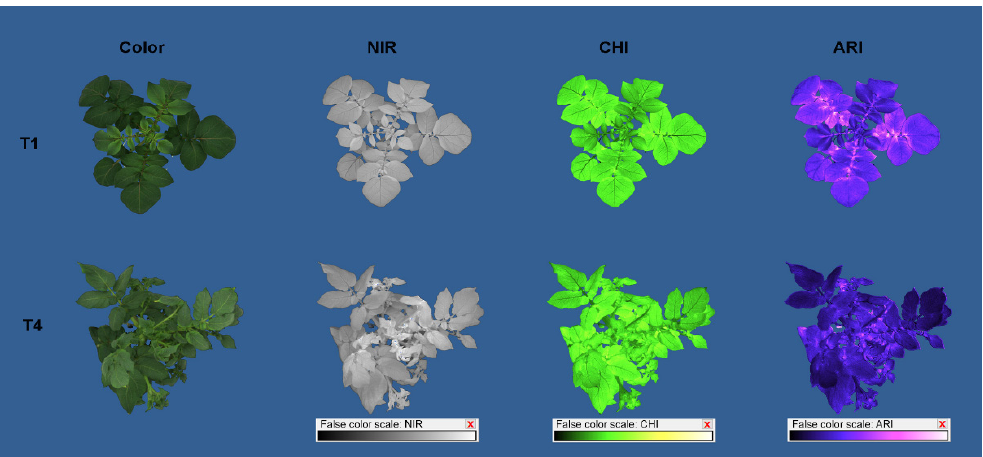
Figure 9. Potato color and pseudo-color images of reflectance in near-infrared (NIR), chlorophyll index (CHI), and anthocyanin index (ARI) captured by CropReporter after ten days of growth in different temperature treatments: 20/15 °C (T1) and 35/30 °C (T4).